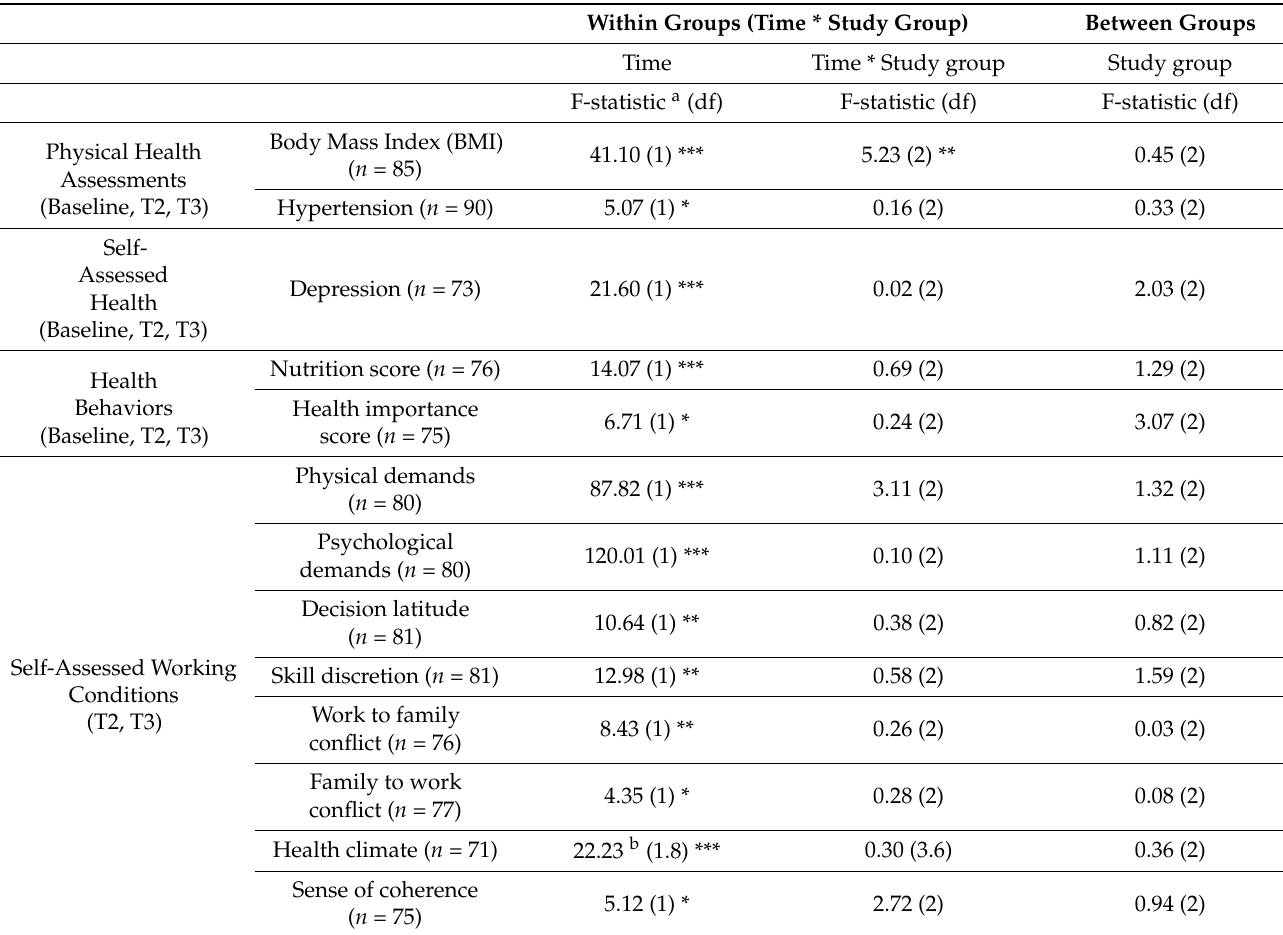
Table 6. Repeated measures comparison across groups for health and working conditions. Within Groups (Time * Study